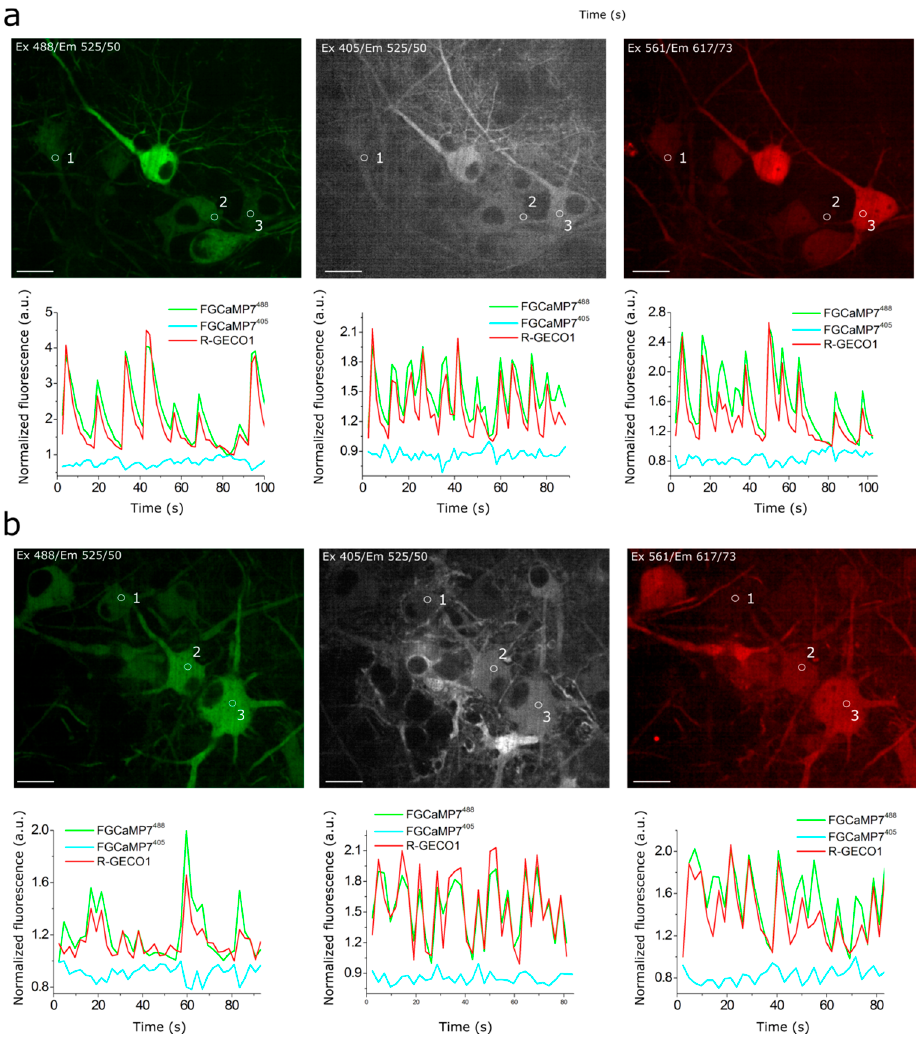
Figure 3. Responses of FGCaMP7 indicator to variations in cytoplasmic calcium concentration in cultured neurons. ( a , b , upper panels) Confocal images of neurons co-expressing ratiometric indicator FGCaMP7 at 488 nm (left panel) and 405 nm (middle panel) excitations and red indicator R-GECO1 at 561 nm excitation (right panel). ( a , b , lower panels) The graphs illustrate changes in green fluorescence of FGCaMP7 at 488 nm (green lines) and 405 nm (cyan lines) excitations and red fluorescence of co-expressed R-GECO1 (red lines) GECI as a result of spontaneous activity in neuronal cultures. Changes in fluorescence are shown for six neurons. The changes shown in graphs correspond to the areas indicated with white circles in the images in upper panels. Scale bar: 20 μ m.